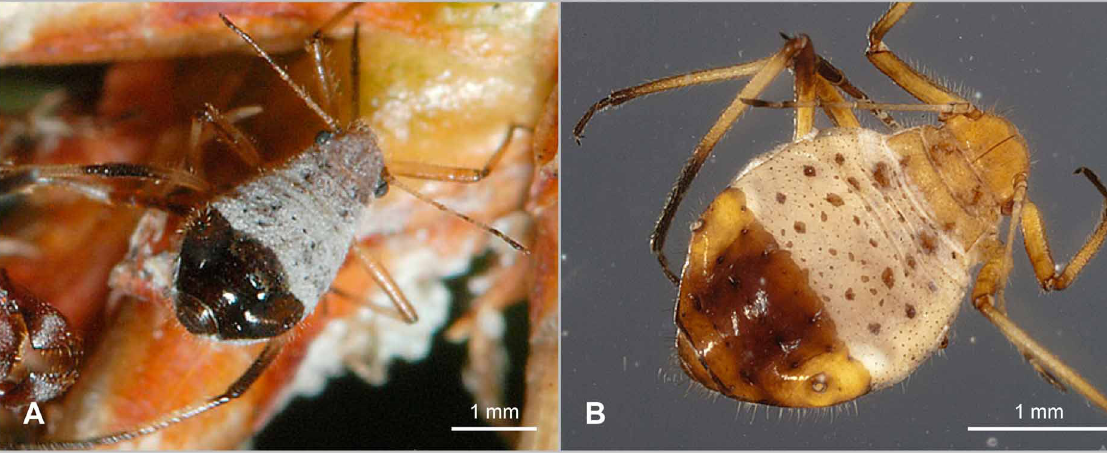
Fig. 98. Cinara (Cinara) brauni Börner, 1940. Apterae. A . In vivo on Pinus nigra . B . In alcohol. From Dransfield & Brightwell 2015 (downloaded on 20 Mar.